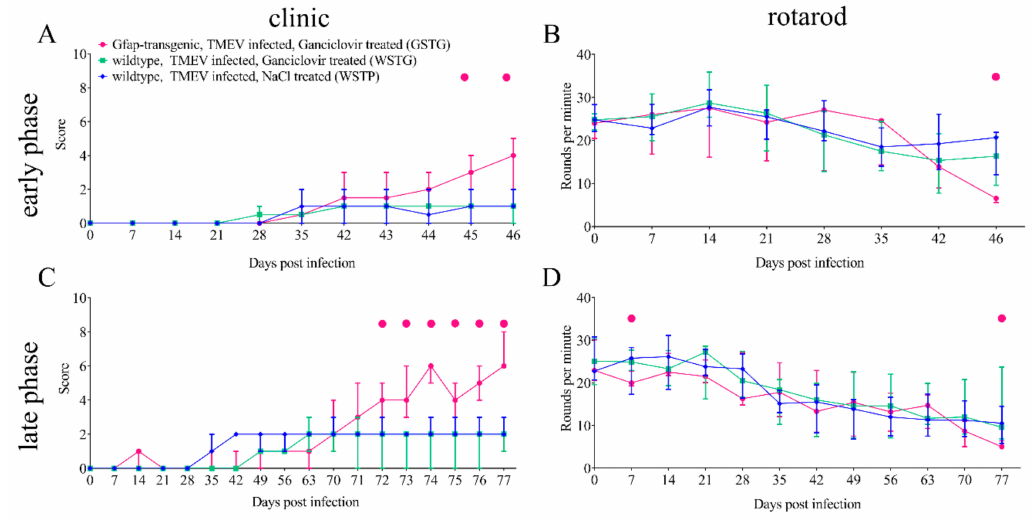
Figure 1. Clinical investigation using a scoring system and a rotarod test. Astrocyte depletion between 28–46 days post infection (dpi; early phase) resulted in a deterioration of clinical signs at 45 and 46 dpi ( A ) and rotarod performance at 46 dpi ( B ) in Theiler’s murine encephalomyelitis virus (TMEV) infected, ganciclovir treated Gfap -transgenic (GSTG) mice as compared with TMEV infected, ganciclovir treated wildtype mice (WSTG). Astrocyte depletion between 56–77 dpi (late phase) resulted in a deterioration of clinical signs starting at 72 dpi ( C ) and rotarod performance at 7 and 77 dpi ( D ) in GSTG as compared with WSTG mice. Clinical and rotarod data are shown as median ± standard deviation.